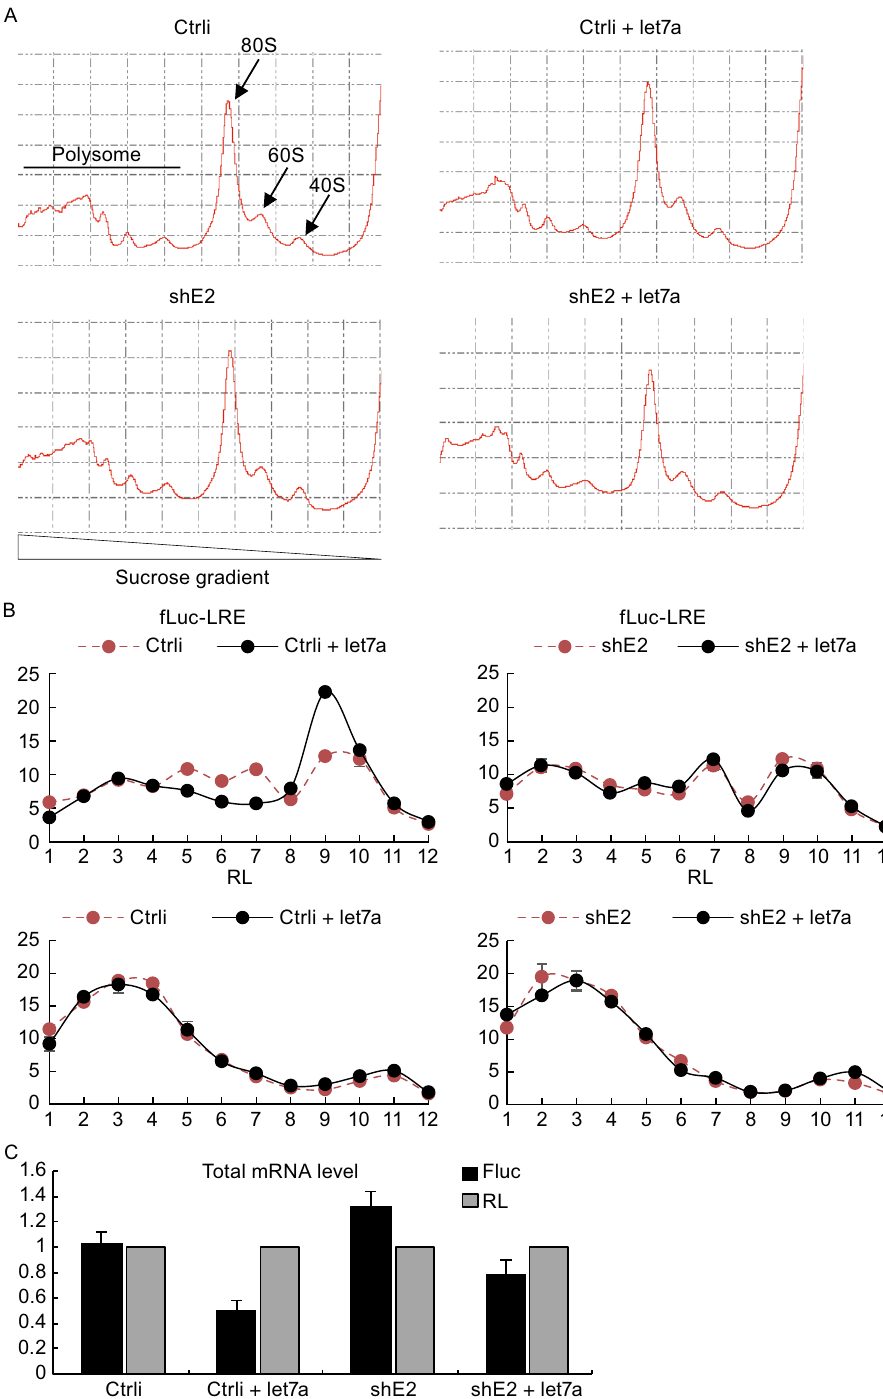
Figure 4. Downregulation of eIF4E2 relieves miRNA repression of target mRNA translation. (A) A control shRNA (Ctrli) or an shRNA targeting eIF4E2 (shE2) were transfected into HEK293 cells with pLRE-fLuc reporter and the control reporter phRL-CMV, together with a plasmid expressing let-7a or a control miRNA. At 48 h posttransfection, the cells were lysed with RNC buffer containing cycloheximide. The lysate was clari fi ed and separated by velocity sedimentation in a sucrose continuous gradient. Fractions were collected and polysome pro fi le was plotted by 254-nm absorption value. (B) fLuc and RL reporter mRNA levels in each fraction were quanti fi ed by RT-qPCR. Y-axis represents the percentage of mRNA in each fraction out of the total mRNA in all the fractions. (C) The total mRNA input before ultra-centrifugation and